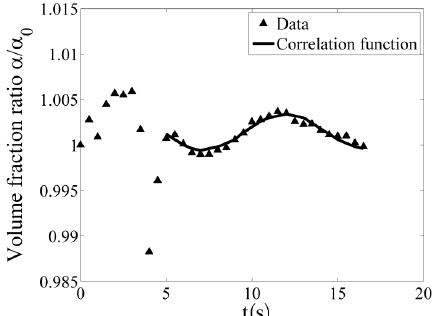
Figure 4. Time-dependent droplet concentration inside the sensor probe slit for a droplet size of 150 nm.